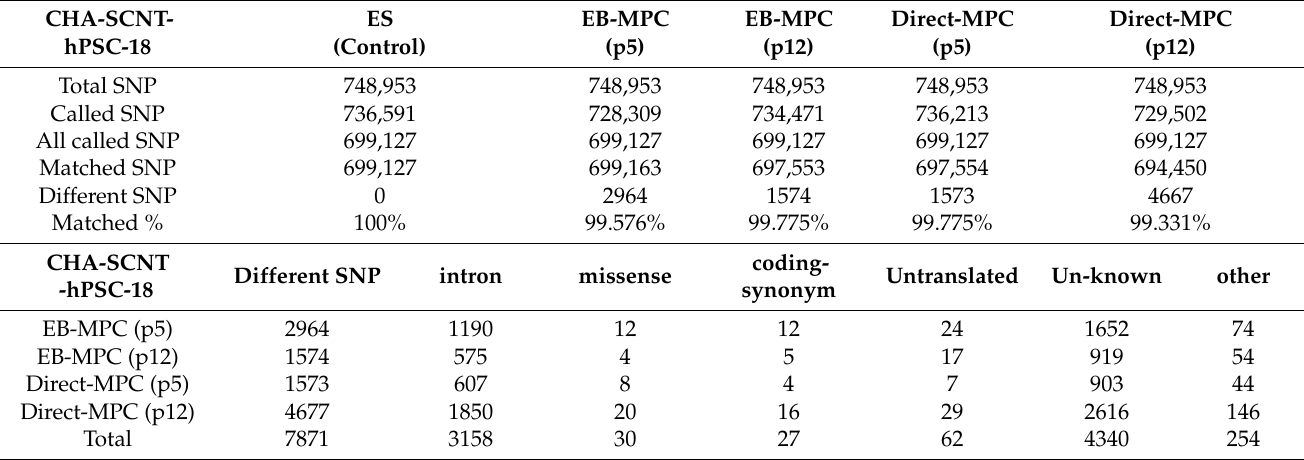
Table 3. SNP analysis of CHA-SCNT-hRSC-18 derived MPCs by array-based comparative genomic hybridization.